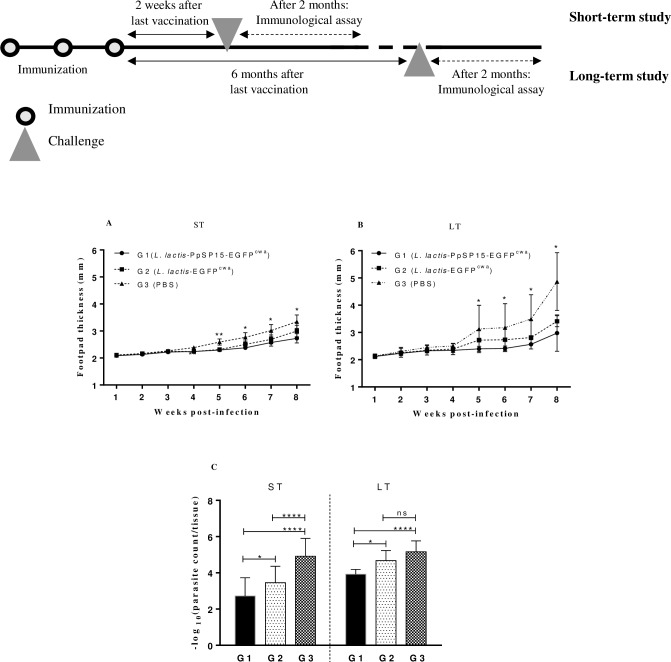
Footpad thickness and parasite burden measurment in BALB/c mice at 2 months after challenge.Schematic figure shows the time schedule for immunization, challenge and analysis during the short- and long term study. Two weeks (ST) or 6 months (LT) after immunization, all groups of BALB/c mice were infected with L. major+SGH, and development of infectivity and effectivity of L. lactis-based vaccine was evaluated through footpad thickness and parasite burden measuring. Footpad thickness in both experiments, ST (A) and LT (B), was meseaured weekly during 8 weeks after challenge by digital caliper. Two months after challenge, LNs from 4–6 mice were isolated, homogenized and after serially culturing the dilutions into the 96-wells plates monitored through weekly microscopical observation to find last dilution containing at least one parasite (C). *Present the statistical differences between different mice groups. * = p<0.05, **** = p<0.0001, ns = non-significant.